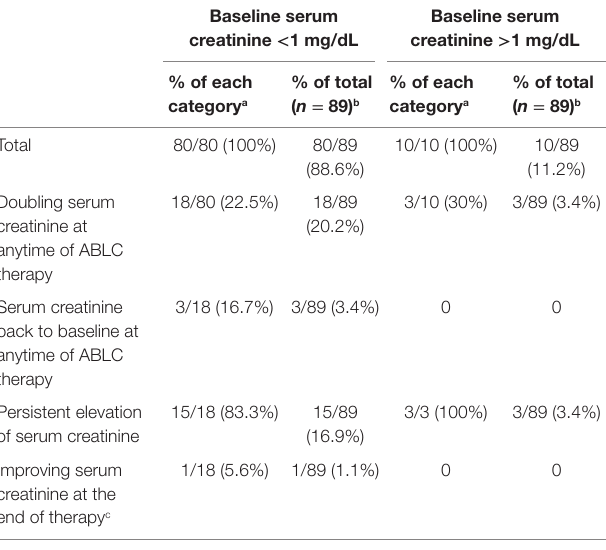
TaBle 3 | nephrotoxicity due to amphotericin B lipid complex (aBlc). TaBle 2 | clinical characteristics, diagnosis, treatment strategy, and